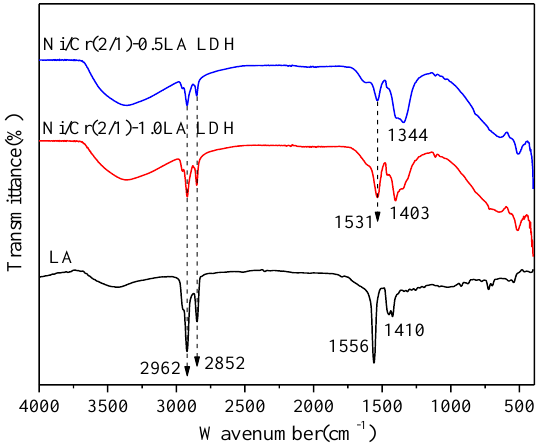
Figure 2. FT−IR spectroscopy of LA and Ni/Cr(2/1)−xLA LDH (x = 1.0, 0.5). Figure 2. FT − IR spectroscopy of LA and Ni/Cr(2/1) − xLA LDH (x = 1.0, 0.5).